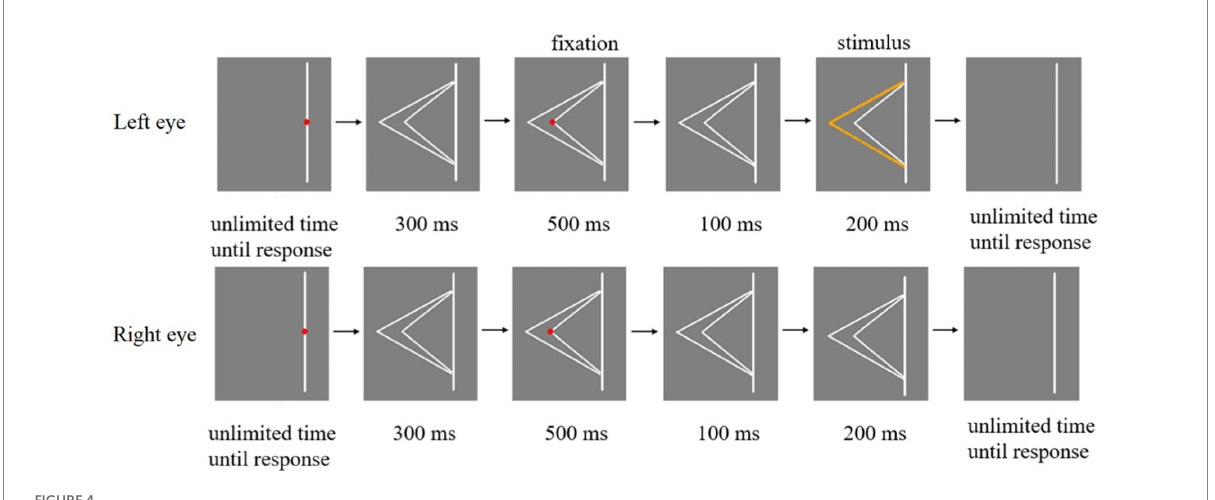
FIGURE 4 Schematic illustration of Experiment 1 procedure.